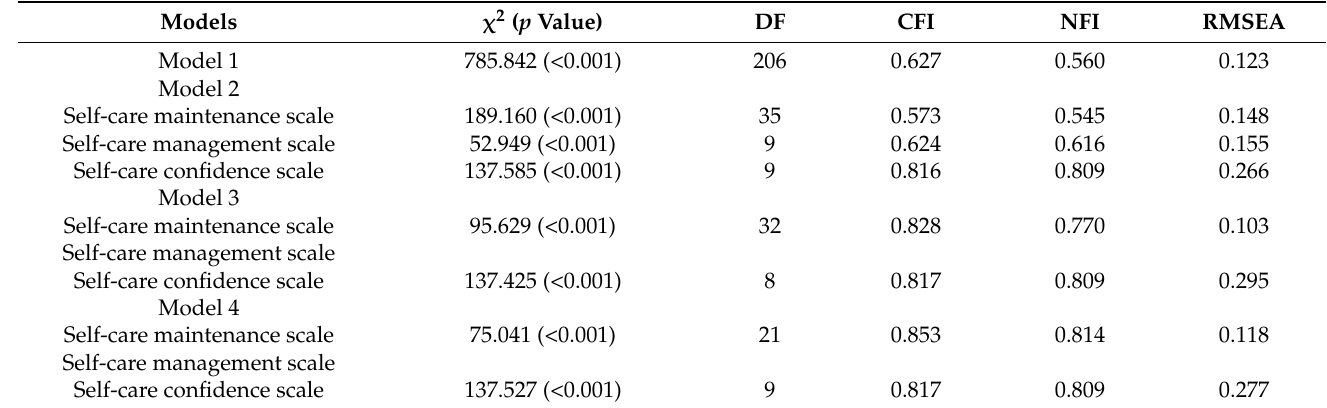
Table 3. CFA fit indices of the tested SCHFI v.6.2 models.